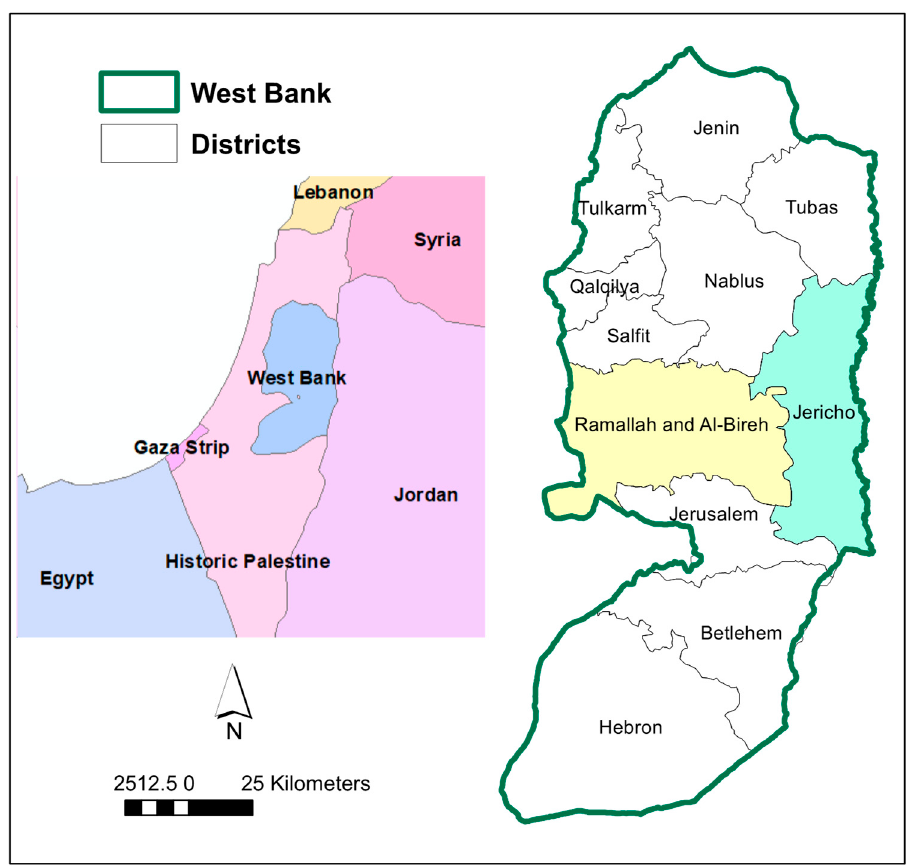
Figure 1. The study area.